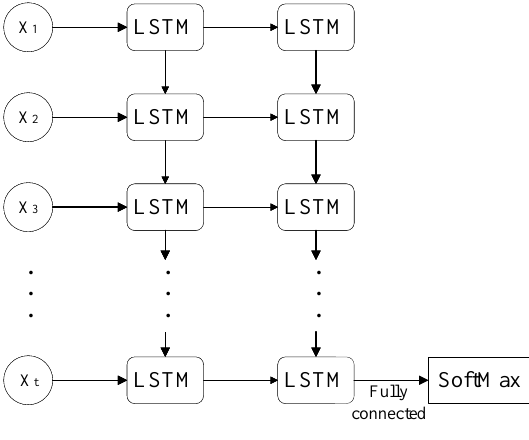
Figure 4. The network structure of a classifier based on